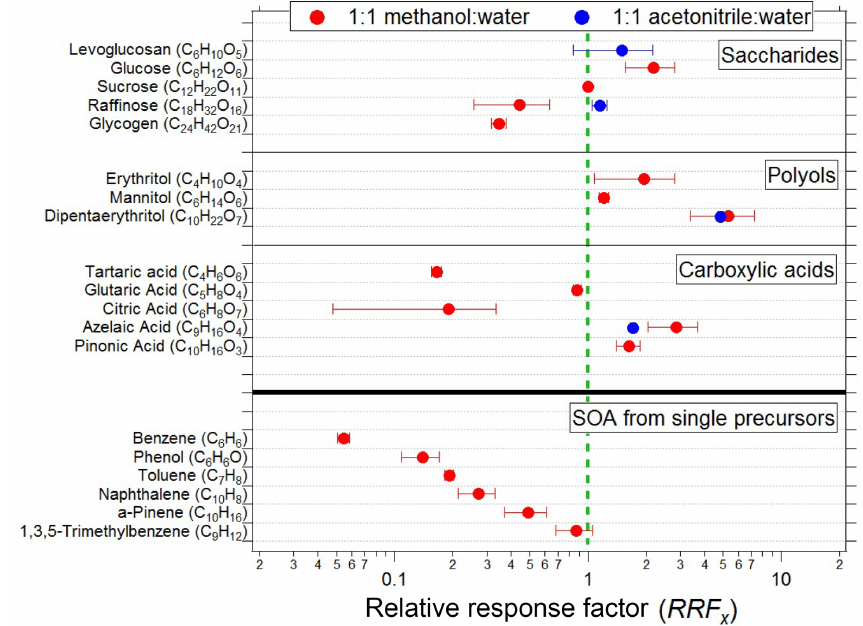
Figure 4. EESI-TOF sensitivity (ionsmolec. − 1 , see Eq. 1) relative to that of sucrose for pure components and SOA formed by OH-initiated oxidation of single precursors in a PAM flow reactor. Red points denote a 1 : 1 methanol–water working fluid; blue denotes 1 : 1 acetonitrile– water. All configurations use 100ppm NaI as a dopant, and all ions are detected as [ M ] Na +